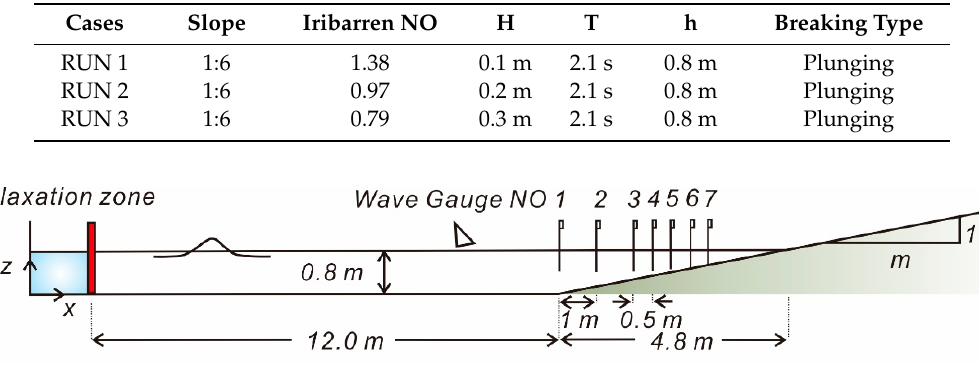
Table 1. List of wave conditions used in the numerical simulations.